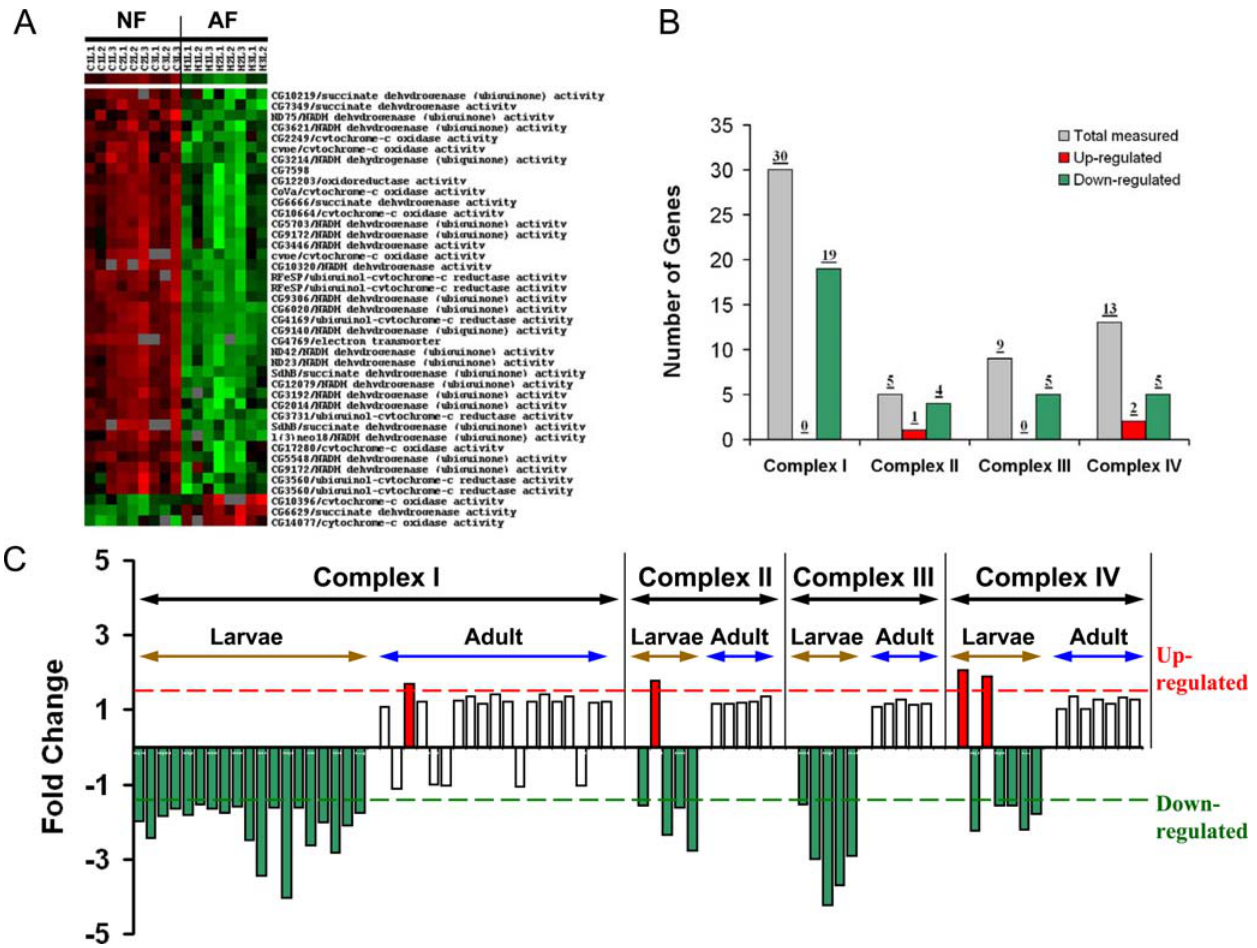
Figure 5. Suppression of genes encoding components of the respiratory chain complexes. A) Cluster map of changes in gene expression encoding components of respiratory chain complexes in NF and AF larvae. Each cluster contained 9 hybridizations of NF and 8 hybridizations of AF samples. B) Summary of alterations in each respiratory chain complex measured in larvae. C) Comparison of gene expression changes in each respiratory chain complex between larvae and